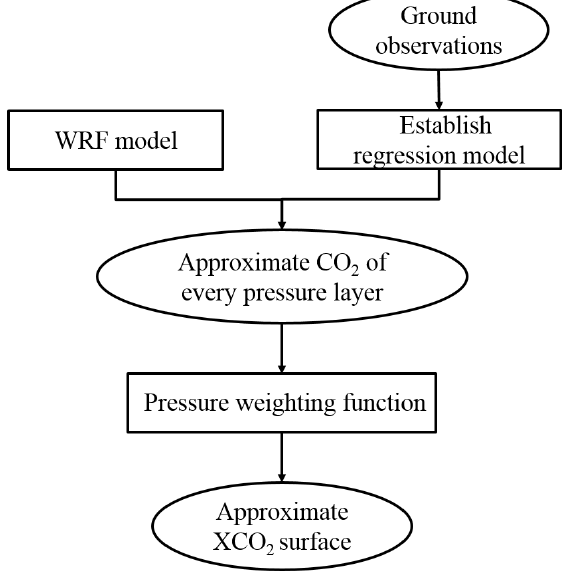
Figure 6. Workflow used to estimate approximate XCO 2 surface.